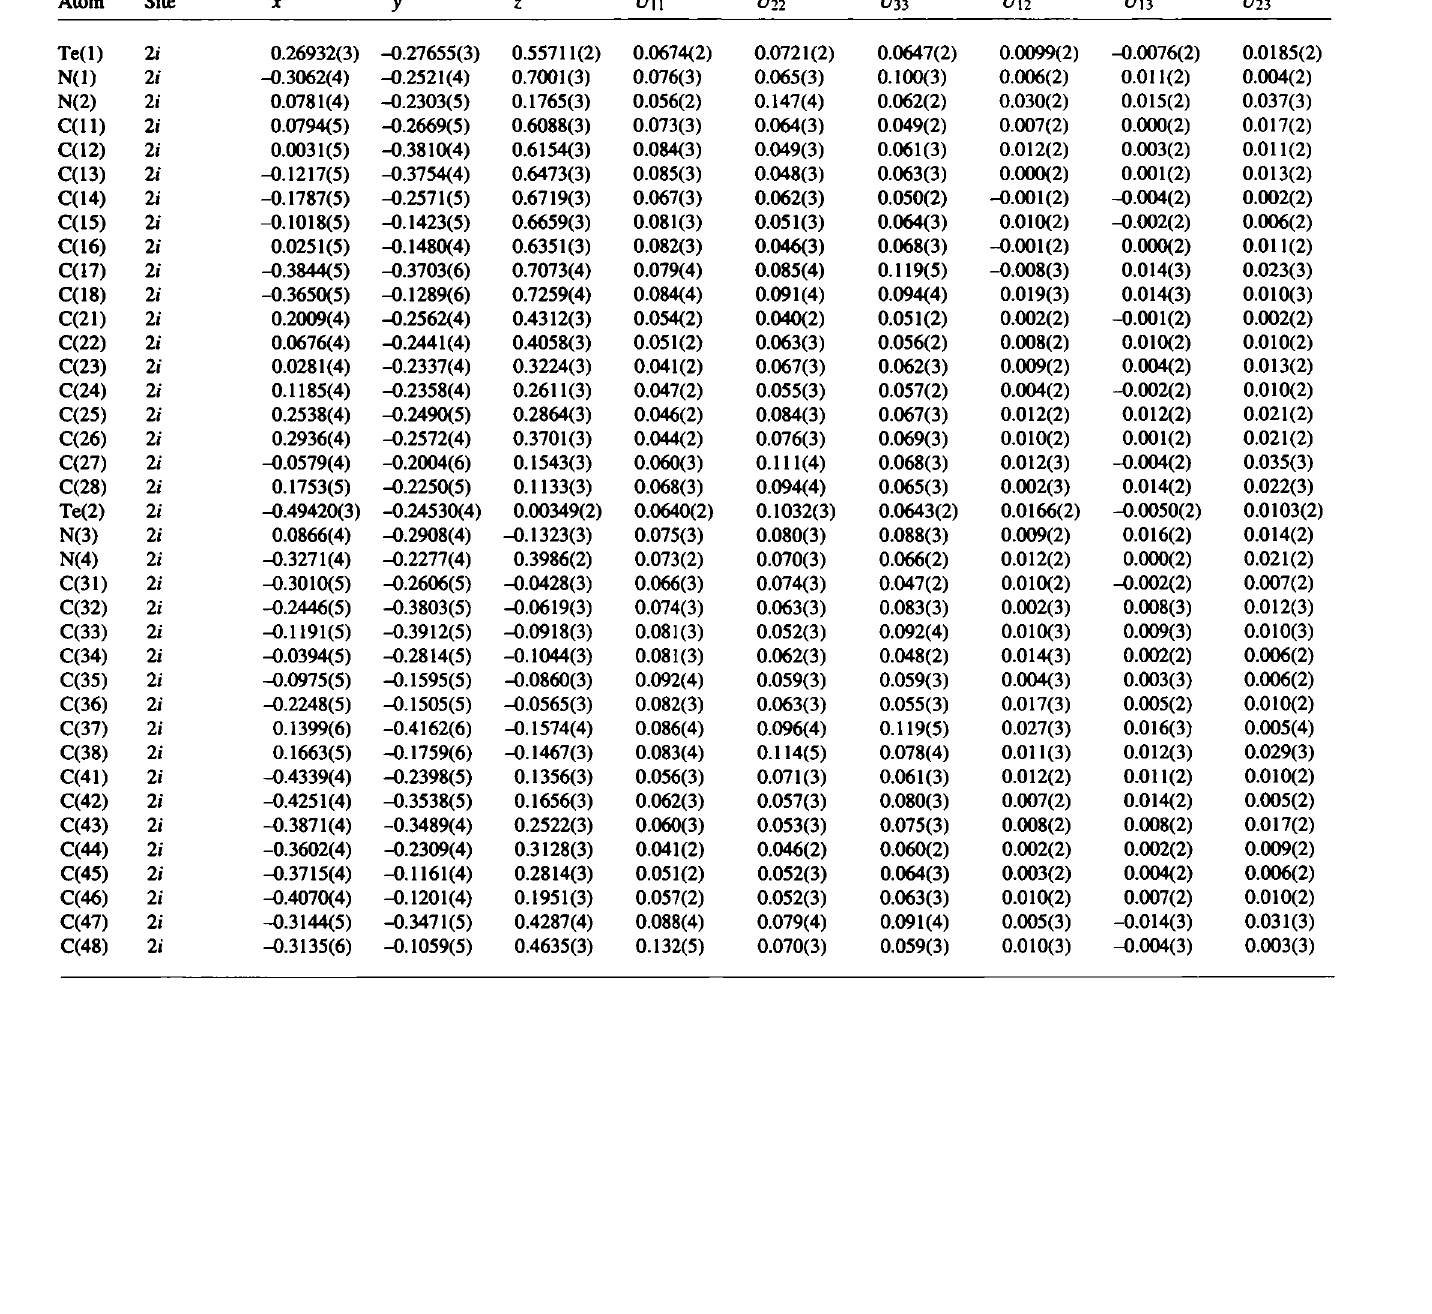
Table 3. Atomic coordinates and displacement parameters (in Â 2